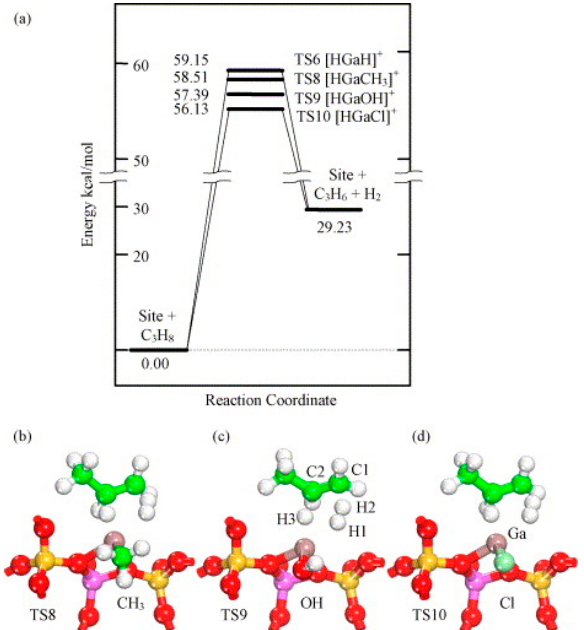
Figure 21. Direct (one-step) dehydrogenation of light alkanes on the Z − [HGaH] + : ( a ) reaction path; transition state geometries for ( b ) X = CH3, ( c ) X = OH and ( d ) X = Cl. Reprinted with permission from ref [119]. Copyright 2005 Elsevier.